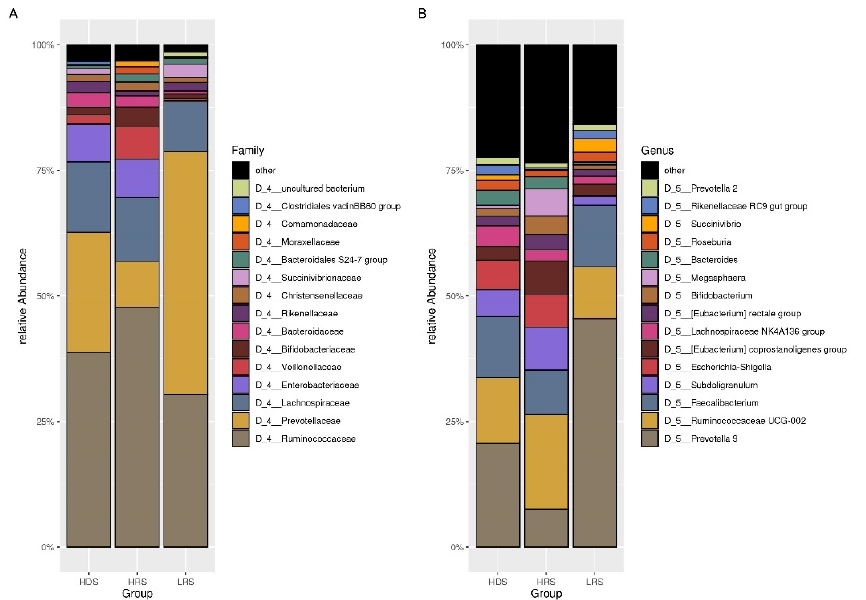
Figure 3. The plot of top 15 relative bacterial abundances. ( A ): the family level. ( B ): the genus level. The groups were based on the season of collection: the heavy dry season (HDS), heavy rainy season (HRS), and the low rainy season (LRS).